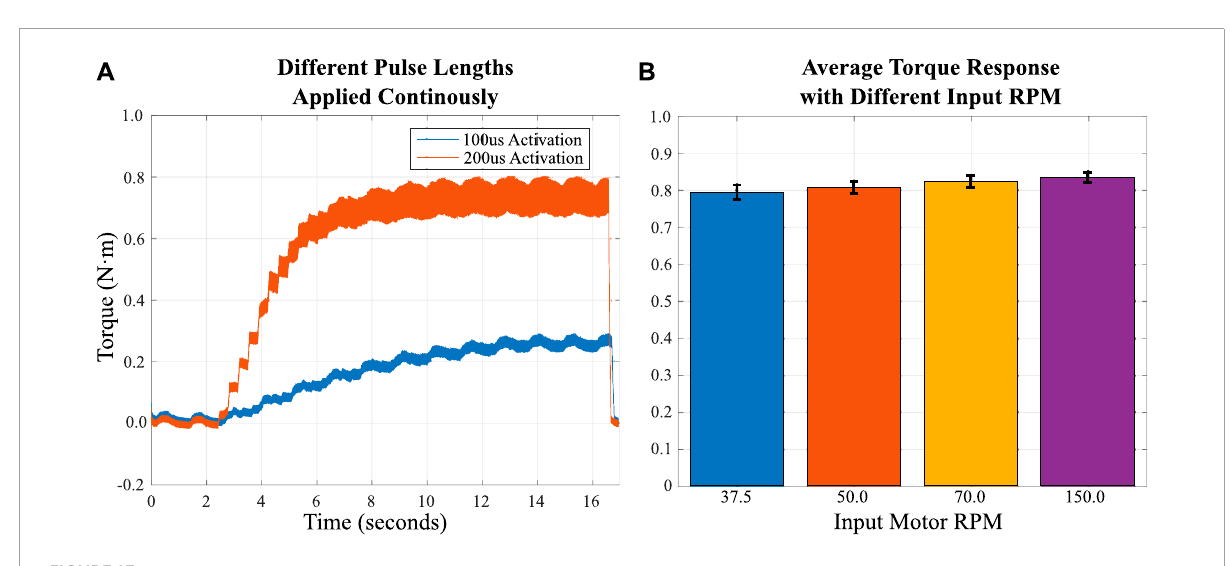
FIGURE 13 (A) This plot demonstrates how cumulative pulses (5 ms to each EPM until all have been activated, with 300 ms in between each step) can gradually bring the torque up to a set maximum, which is determined by the pulse length. (B) This bar plot compares how RPM affects maximum transmitted torque, with all EPMs being full